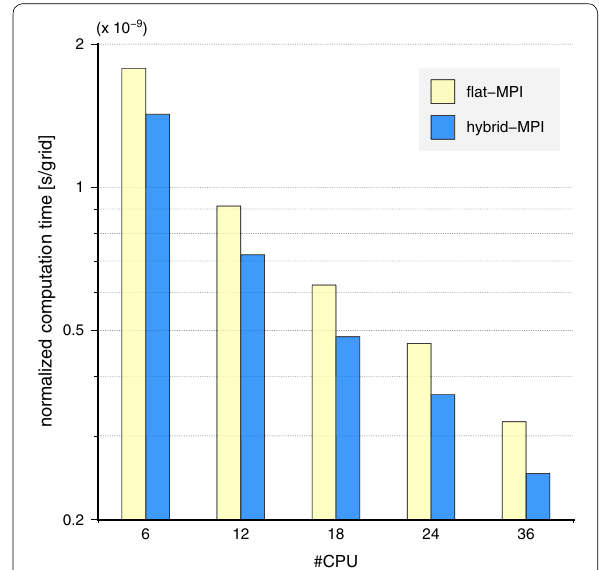
Fig. 7 Speedup of the computational time of the 3D simulation code with increasing numbers of CPUs for different model sizes and com- puter systems. The computation time of each model is normalized by the FDM grid numbers (see text for details)